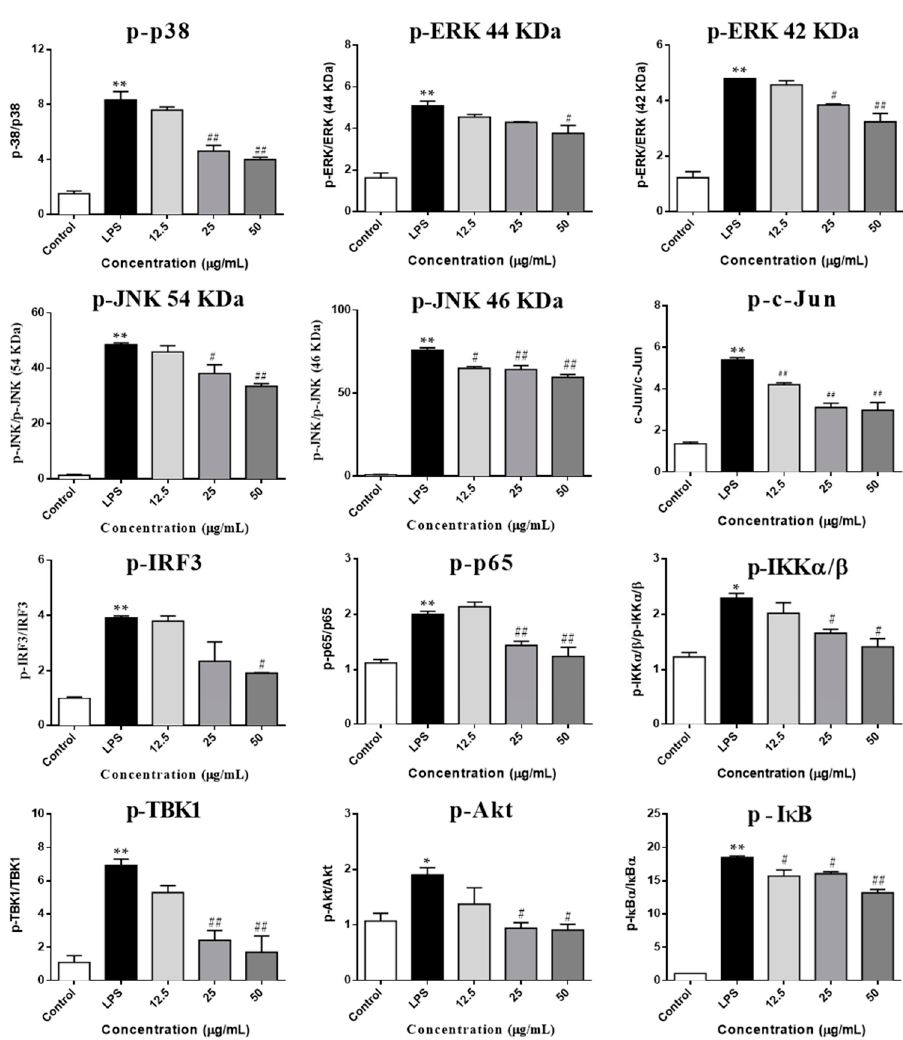
Figure 6. Effect of SCL on the components of IKK α / β /NF- κ B, MAPKs/AP-1 and TBK1/IRF3 pathways in LPS-stimulated RAW264.7 cells. The data presented in bar charts indicates the ratio of p-IKK α / β /IKK α / β , p-I κ B α /I κ B α , p-TBK1/TBK1, p-p38/p38, p-ERK/ERK (44 KDa), p-ERK/ERK (42 KDa), p-JNK/JNK (54 KDa), p-JNK/JNK (46 KDa), p-p65/p65, p-c-Jun/c-Jun, p-IRF3/IRF3, and p-Akt/Akt in RAW264.7 cells. Values given are the mean ± SEM of 3 independent experiments; * p < 0.05, ** p < 0.01 vs. unstimulated cells. # p < 0.05, ## p < 0.01 vs. LPS-stimulated cells using a one-way ANOVA followed